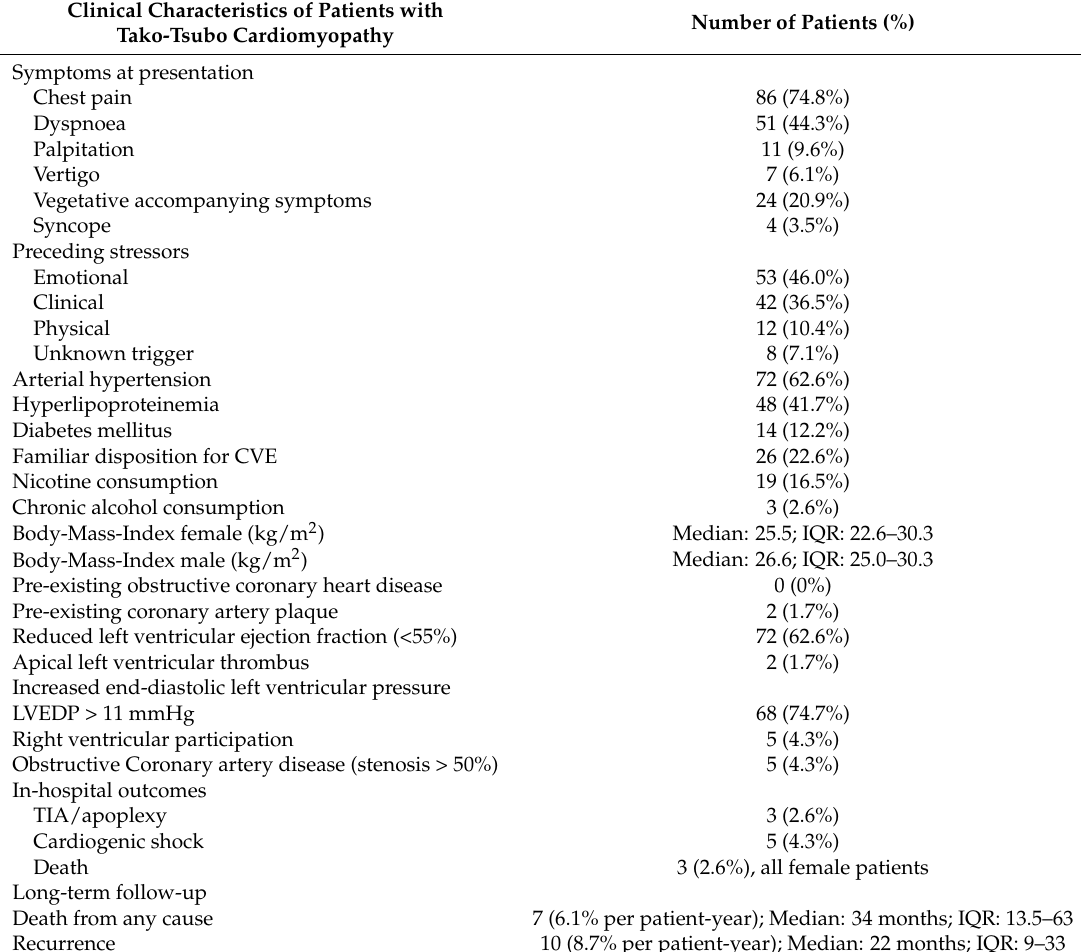
Table 1. Clinical characteristics of our Tako-Tsubo cardiomyopathy (TTC) patients (total number, n = 115; multicenter registered analysis)—CVE: cardiovascular event, LVEDP: left ventricular end-diastolic pressure, TIA: transient ischemic